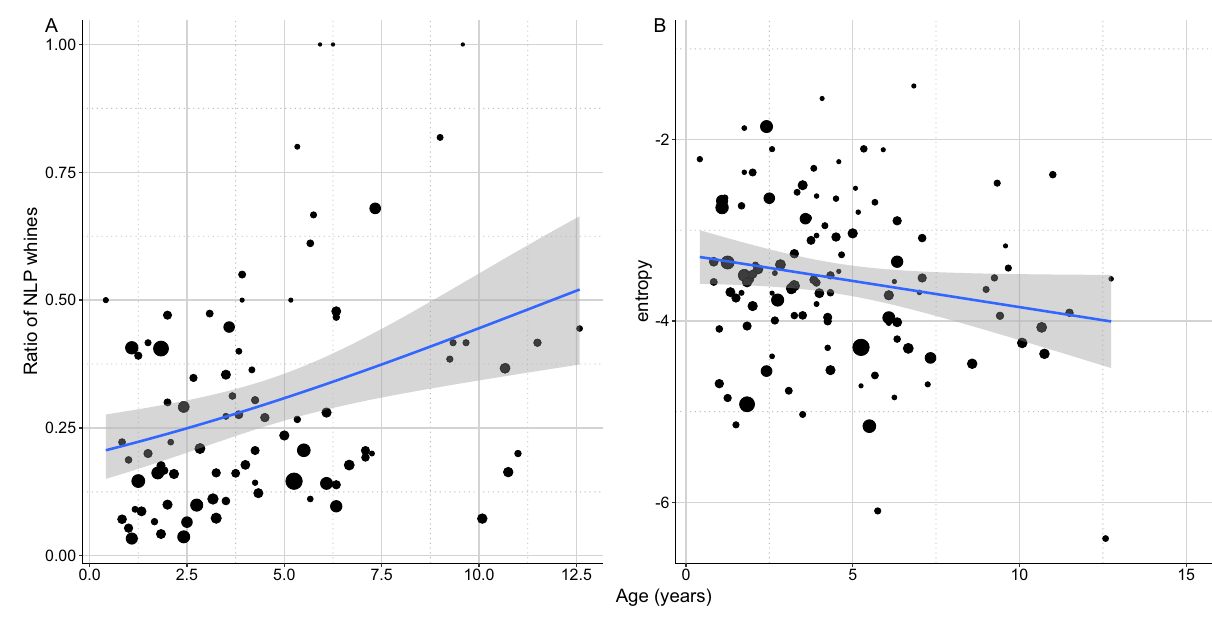
Figure 5. ( A ) The positive relationship between the ratio of NLP whines produced by the dog during the separation test and the dog’s age. ( B ) The negative relationship between the entropy of whines produced by the dog during the separation test and the dog’s age. The size of the dots is proportional with the number of whines produced. The grey field shows the 95% confidence interval of the linear